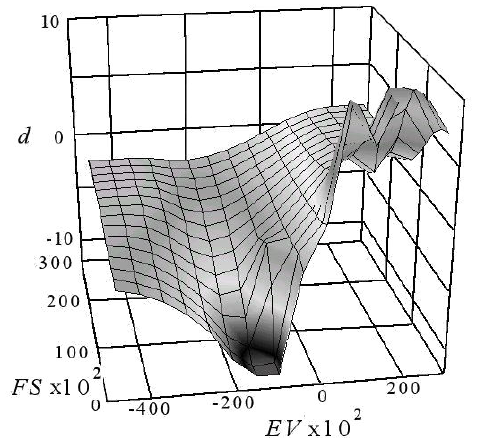
Figure 23. d divergence coefficient and chaos between peak A and equilibrium